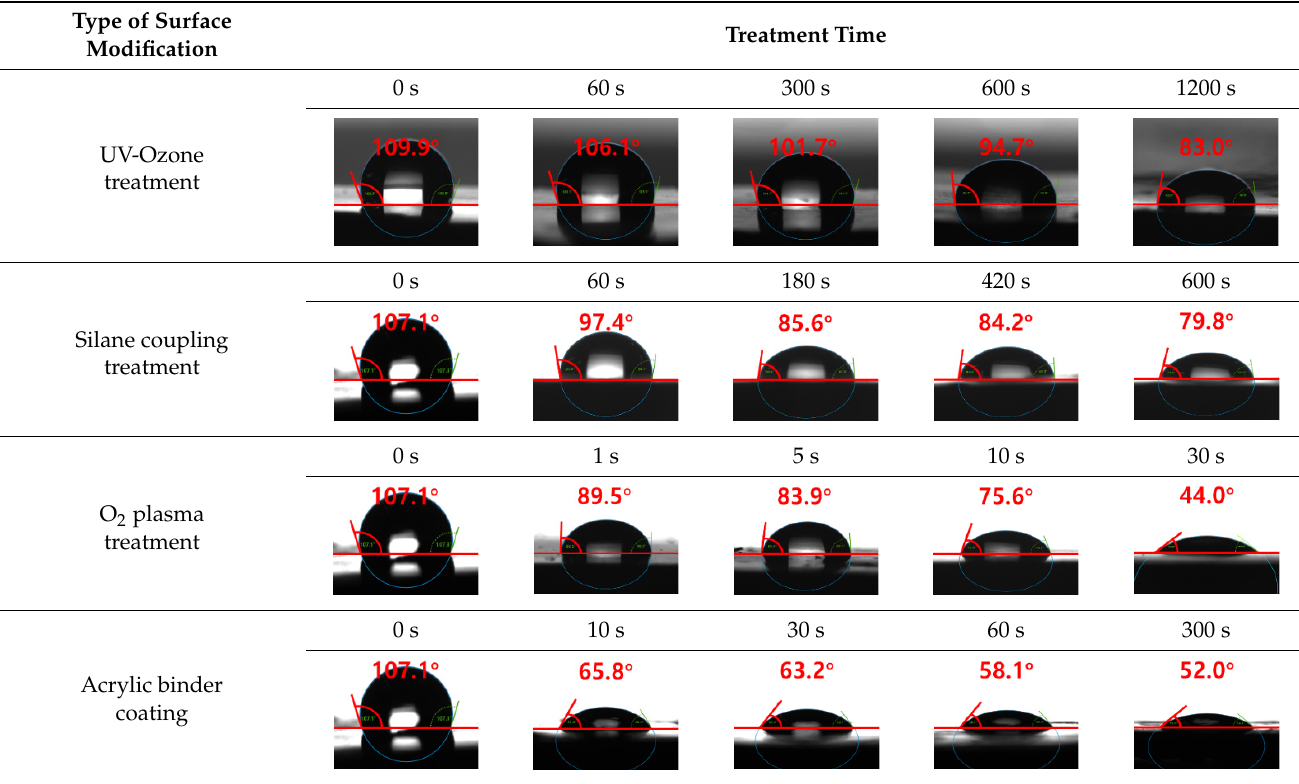
Silane coupling